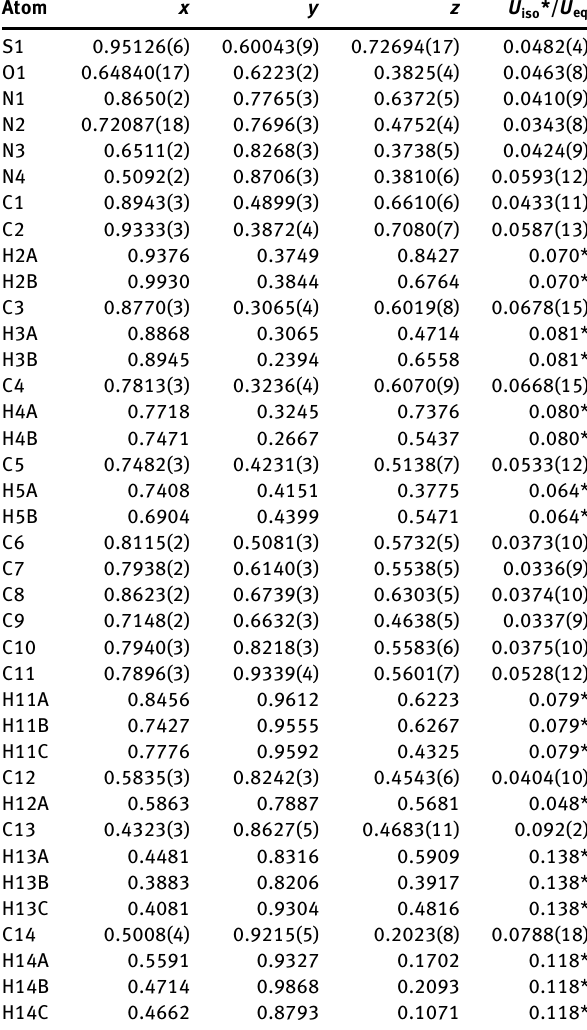
Table 2: Fractional atomic coordinates and isotropic or equivalent isotropic displacement parameters (Å 2